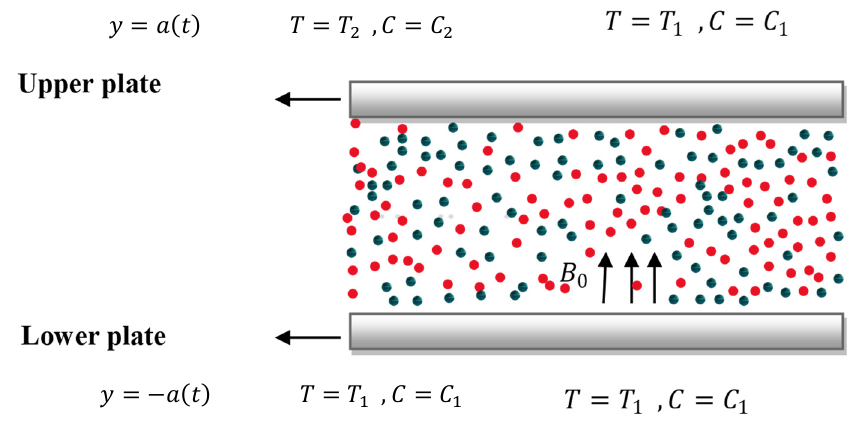
Figure 1. Physical